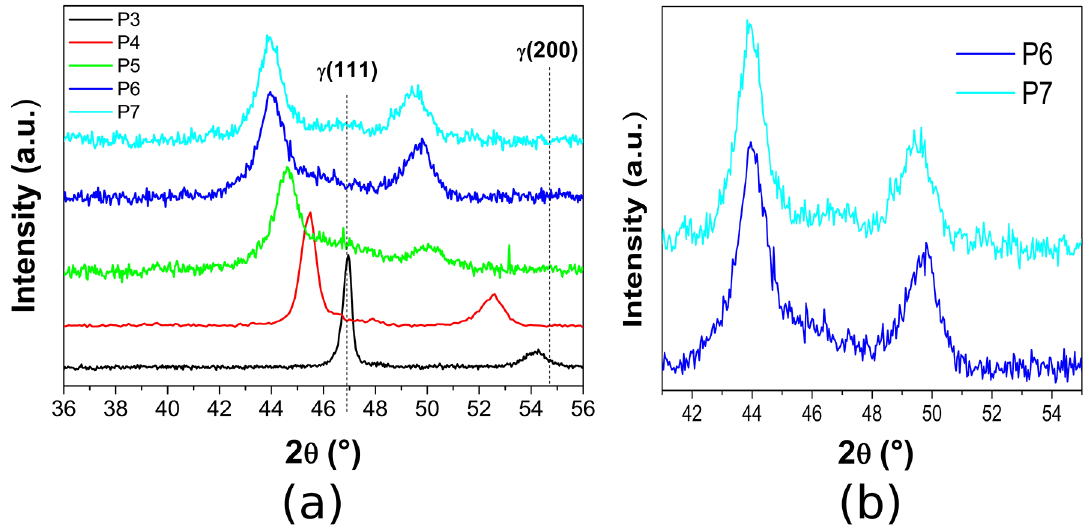
Figure 7. GAXRD patterns (θ=2°) of the reflections (111) and (200) (a) for all the nitrided samples, (b) zoomed, for 6 and 7